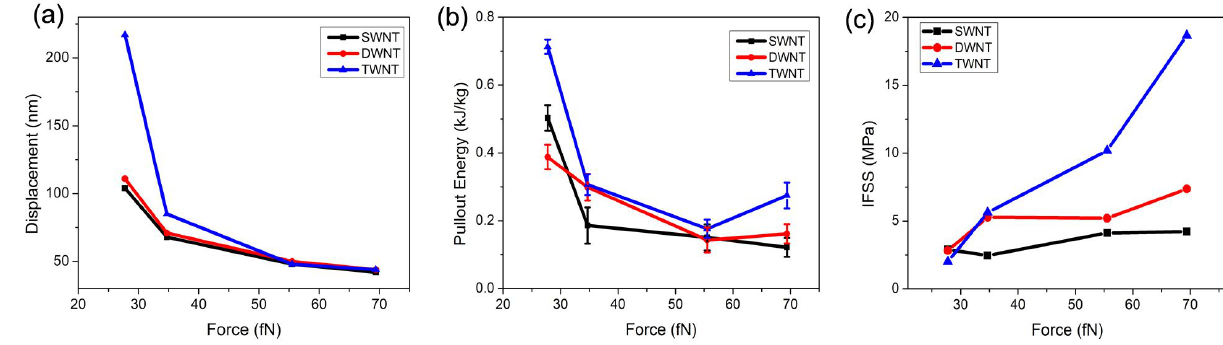
Figure 8: Comparison of properties of nanocomposite systems with a SWCNT, DWCNT, and TWCNT as a function of the external force; (a) displacement change; (b) pullout energy; (c) interfacial shear